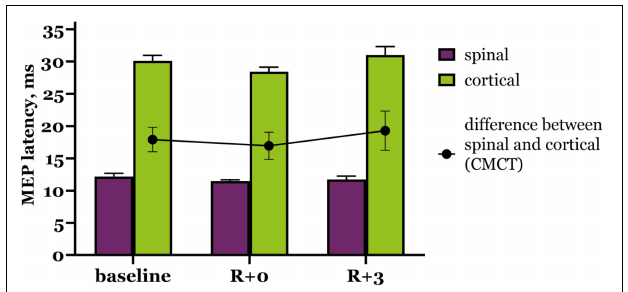
FIGURE 3 | Motor evoked potential latency to trans-spinal (purple bars) and transcranial (green bars) MS. Black dots represent CMCT values. R + 0 – day of DI completion, R + 3 – third day after